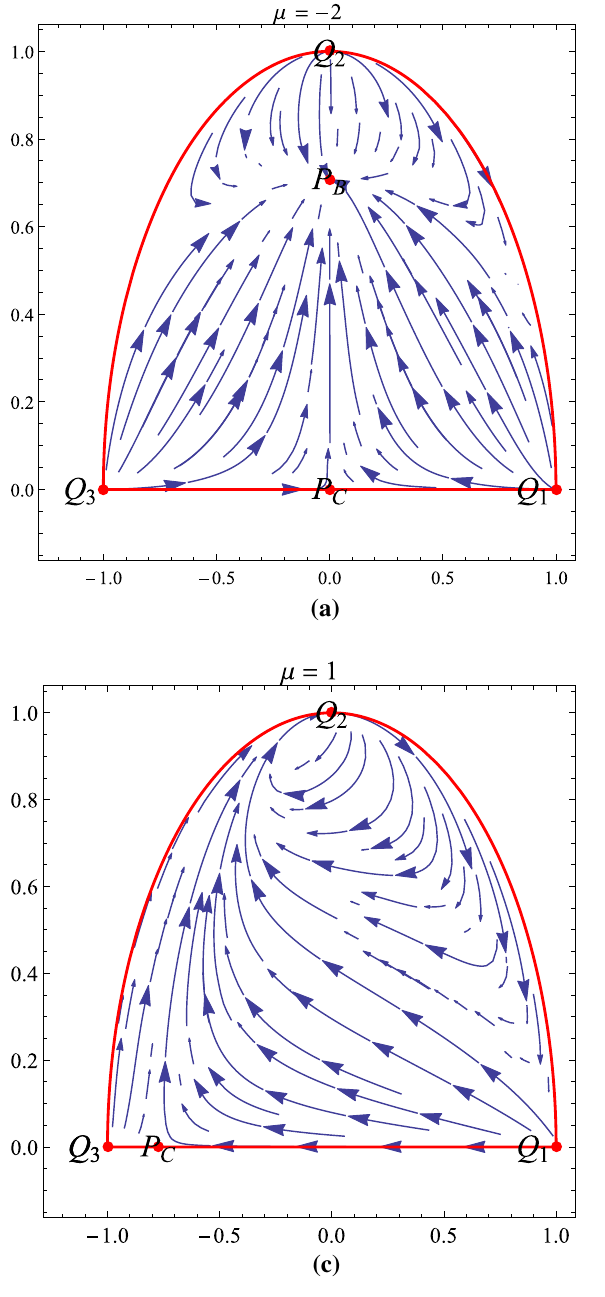
Fig. 1 Orbits of the system (92) for some values of parameter μ in the Poincarè variables ( U , V )